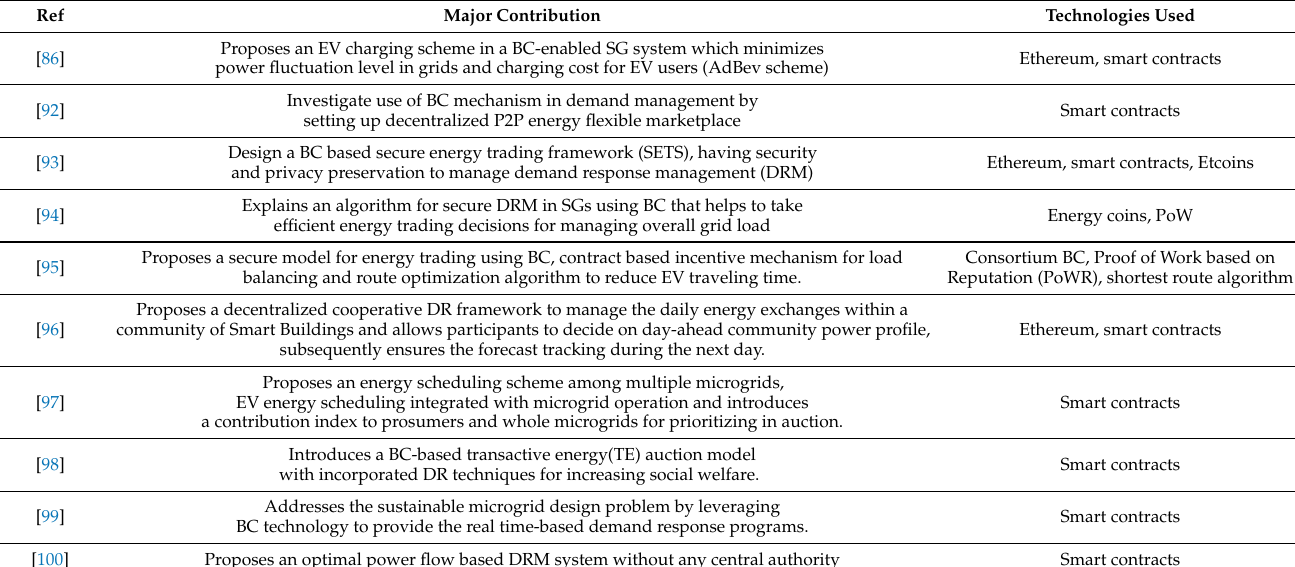
Table 7. Summary of existing works related to demand response management using